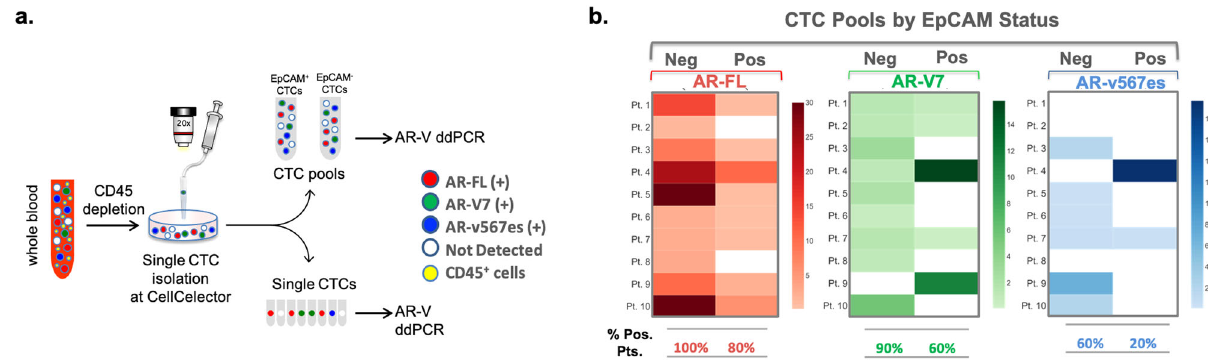
Fig. 3 Expression of AR-FL, AR-V7, and AR-v567es in EpCAM pos and EpCAM neg CTC pools in patients with mCRPC. a Experimental outline: CTCs were enriched from mCRPC patients by CD45 negative depletion followed by single-cell isolation using the CellCelector TM micromanipulator. b Pools of EpCAM pos /CD45 neg or EpCAM neg /CD45 neg CTCs were isolated from 10 patients with mCRPC and processed for quanti fi cation of each AR transcript by ddPCR. Data were normalized by the number of CTCs in each pool. Heatmap of AR-FL, AR-V7, and AR-v567es expression per patient and per EpCAM status (AR-FL, red; AR-V7, green; AR-v567es, blue; not detected, white).